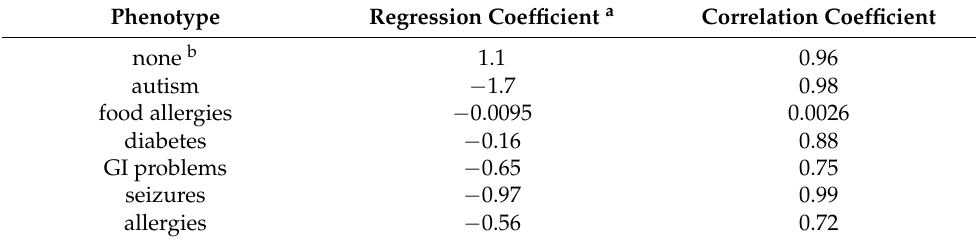
Table 5. Linear regression analysis of FXS comorbidities as a function of time on breast milk.